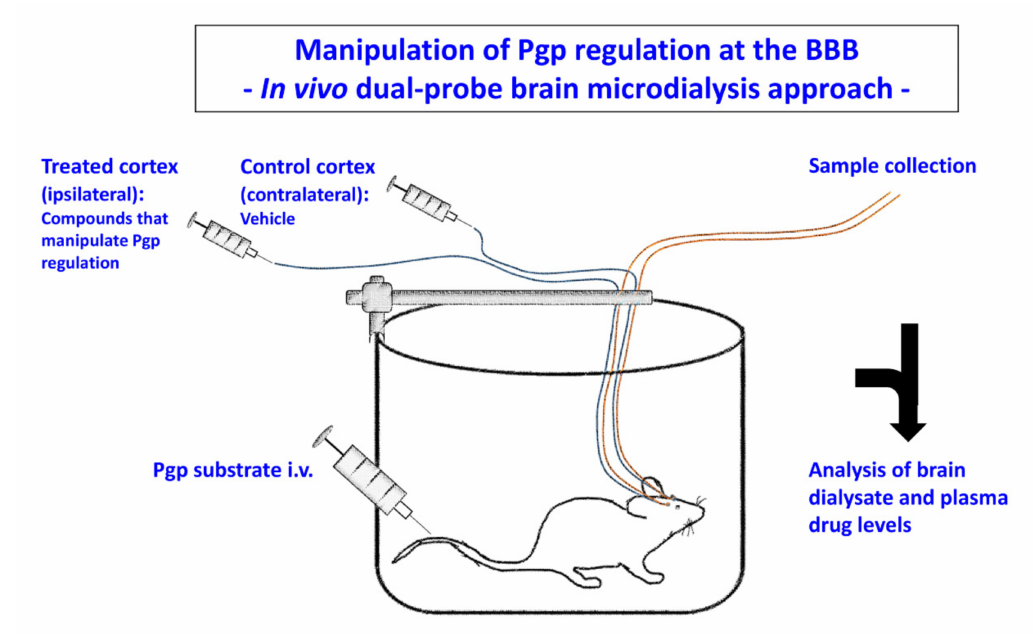
Figure 8. Dual-probe intracerebral microdialysis in studies on Pgp-mediated restriction of drug penetration across the BBB. The experimental protocol used by us for this purpose is similar to the protocol described by Burgio et al. [195] for studying the involvement of Pgp in the control of brain distribution of the chemotherapeutic agent etoposide. In short, rats are implanted with two microdialysis probes in the left and right motor cortices. One probe is infused with an aqueous Ringer’s solution containing a compound that interferes with Pgp regulation at the BBB (e.g., a Pgp inhibitor) and the other probe is infused with Ringer’s solution and the vehicle used for dissolving the compound. Then, a Pgp substrate is injected systemically (intraperitoneally or intravenously), and plasma and dialysate concentrations are repeatedly determined over the course of an experiment in conscious, freely moving rats. Since only one cortex is treated with a compound, the vehicle-treated cortex served as a control site in each individual rat. Redrawn and modified from Löscher and Potschka